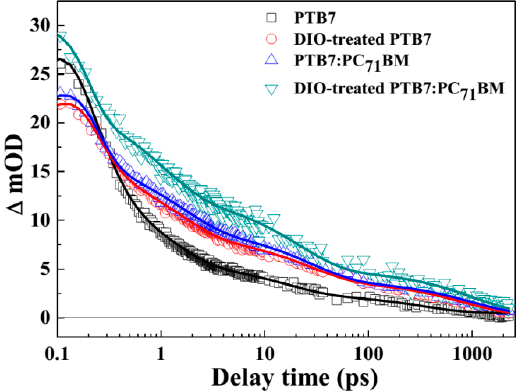
Figure 6. Kinetic curves of PTB7-based photoactive layers at a probe wavelength of 862 nm. All data were fitted by multi-exponential functions. All active layers were excited at 690 nm and the excitation photon fluence was 3.7 × 10 13 photons · cm − 2 · pulse − 1 at room temperature. Table 2. Decay time constants ( τ , ps) and amplitude values (a, mOD) derived from multi-exponential curve fitting of the kinetics for PTB7-based photoactive layers. Fitting Parameters and Apparent Lifetimes Active Layers